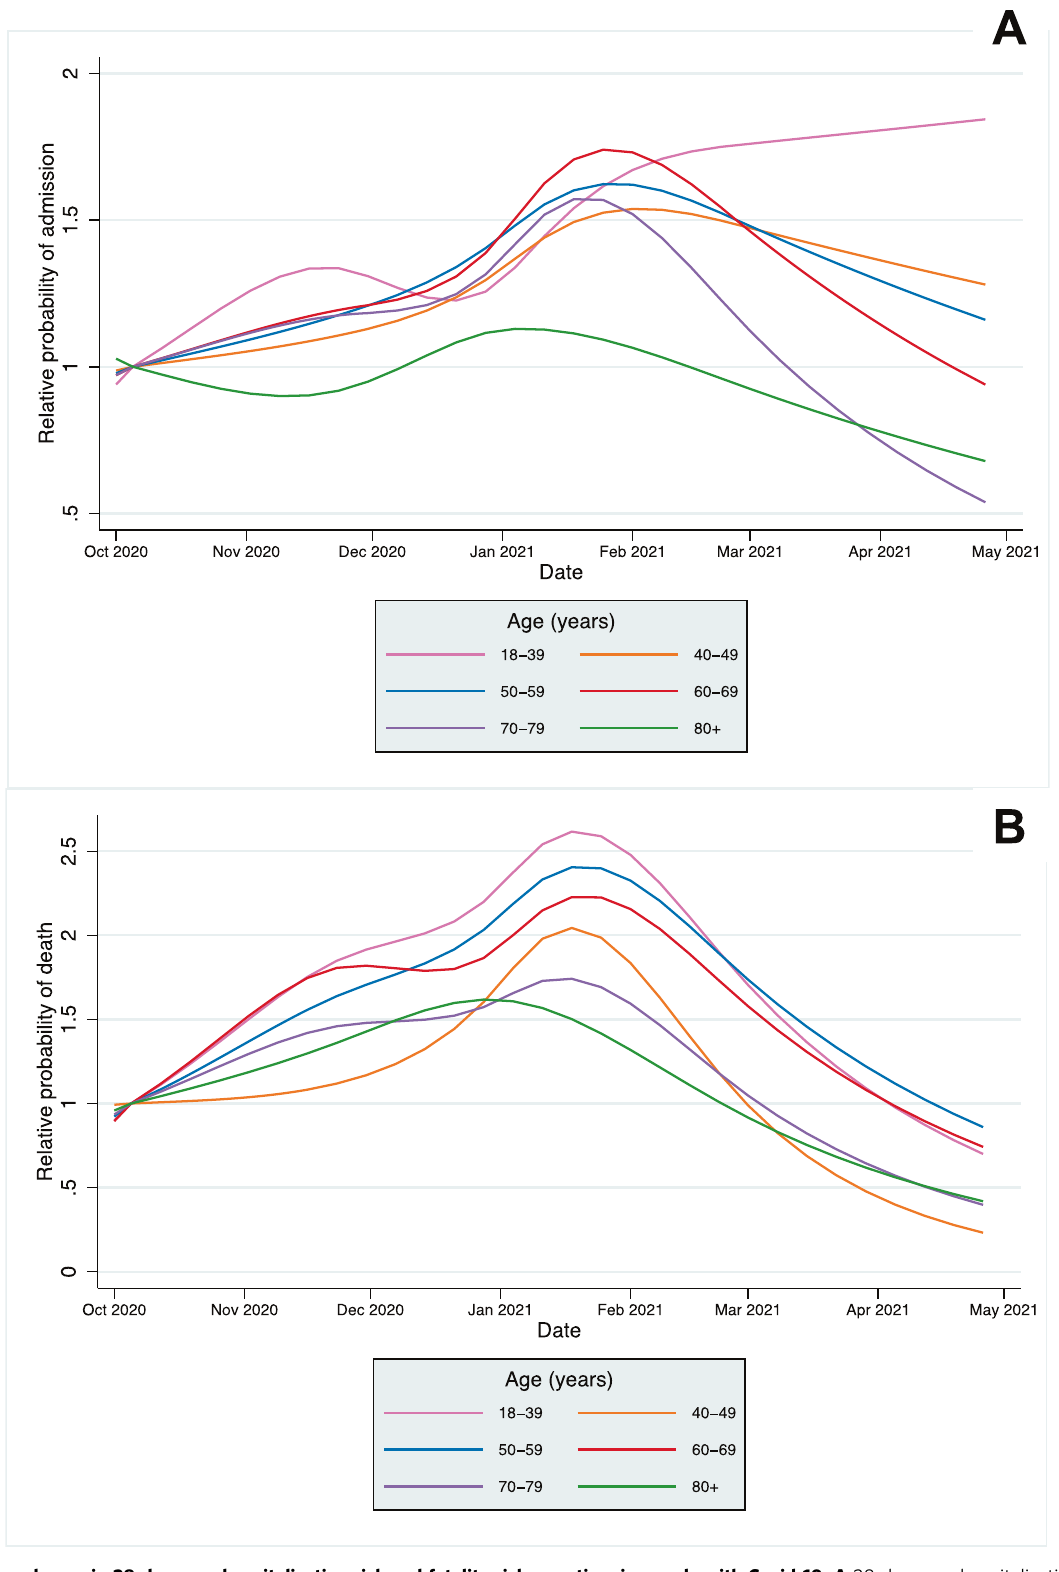
Fig. 4 Relative change in 28-day case hospitalisation risk and fatality risk over time in people with Covid-19. A 28-day case hospitalisation. B 28-day case fatality risk. Lines represent the probability estimate for each age group from mixed effects logistic regression models, adjusted for patient-level covariates, at mean levels of each covariate ( N = 2,311,282). Y-axis is the probability relative to the fi rst full week of October; note different scales for admissions and